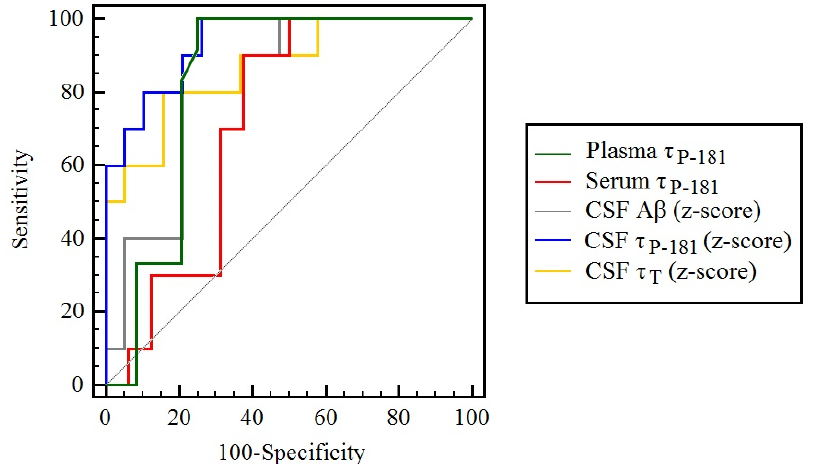
Figure 2. Receiver Operating Characteristics curves of the studied biomarkers. The gray diagonal